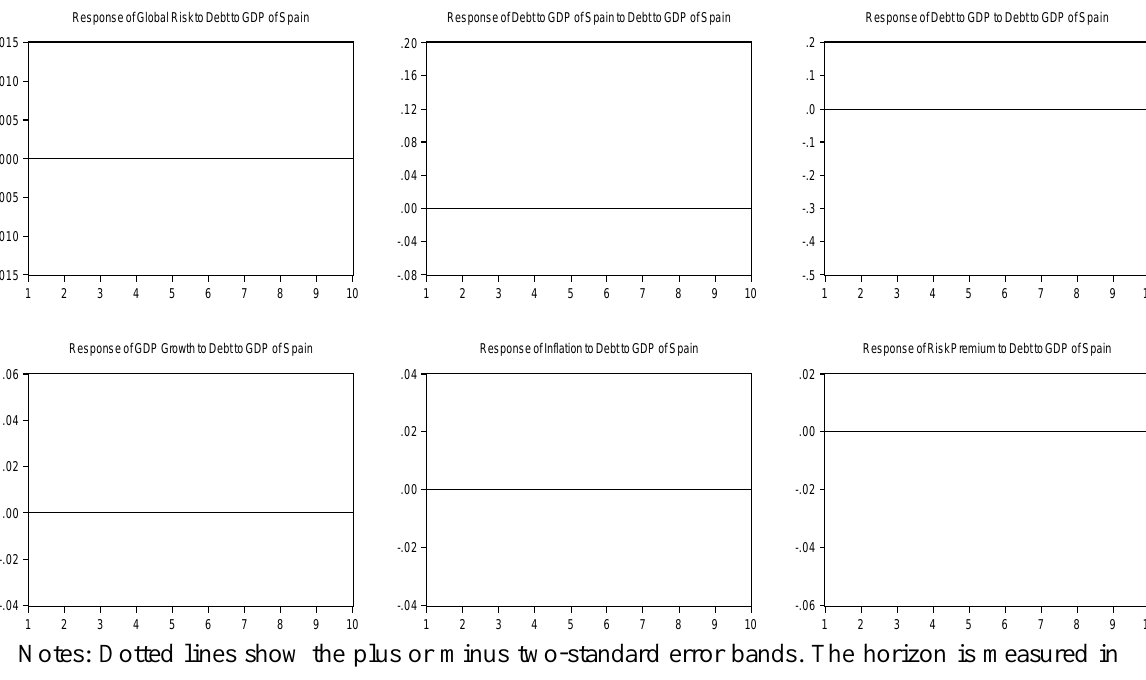
Figure 13. Pre-crisis response of EMU countries to a shock to Spanish debt-to-GDP ratio: